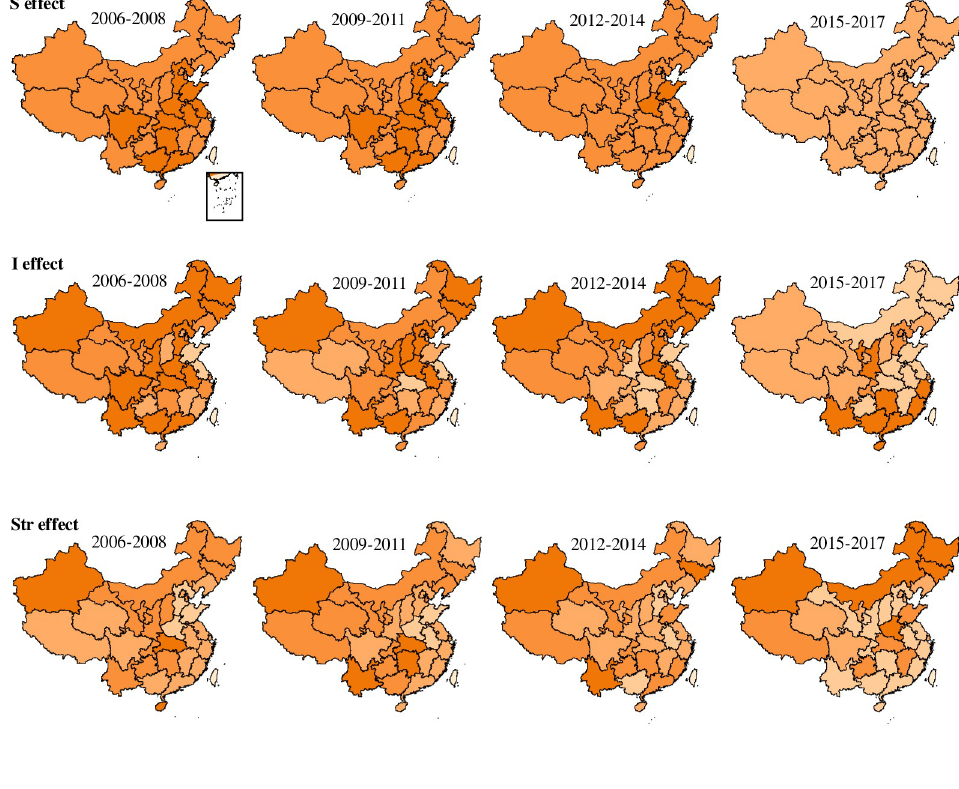
Fig 6. Temporal and spatial differences in the driving effect of FU in China. Figures are drawn by the authors according to the standard map of the National Surveying and Mapping Geographic Information Bureau (Approved drawing number: GS (2016) 2921) (http://bzdt.ch.mnr.gov.cn/). All maps on this website are available for free download without copyright.